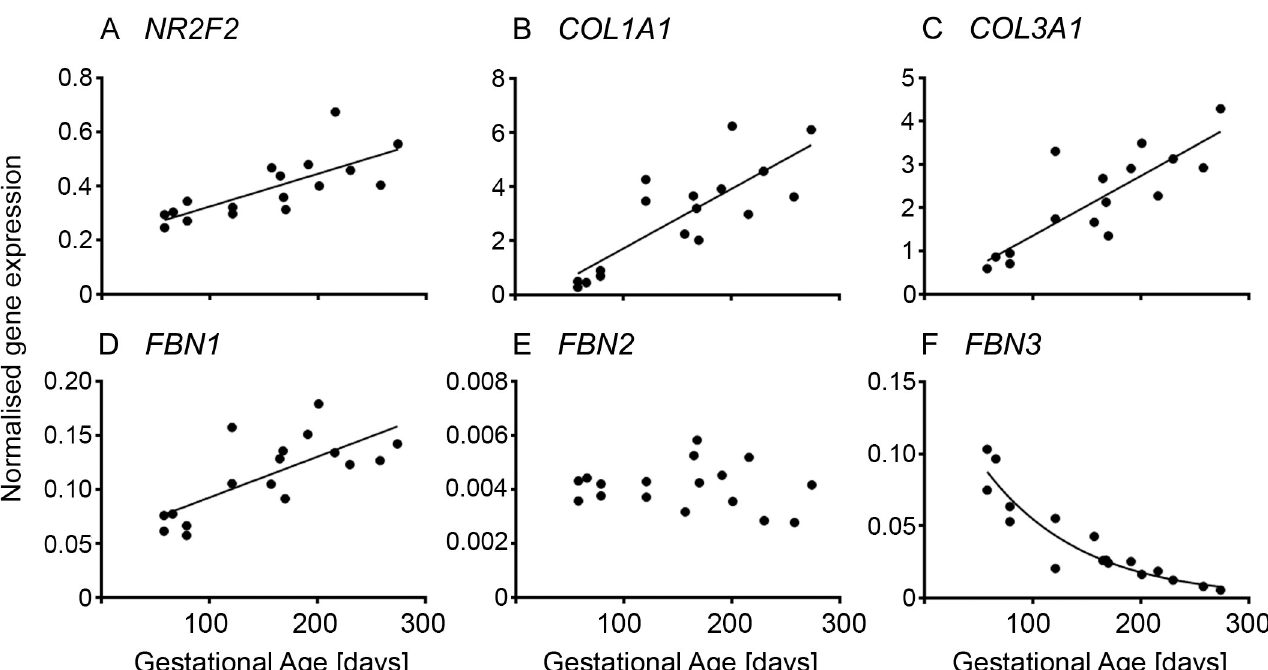
Fig 2. Stromal matrix and marker in fetal ovarian development. Expression levels of genes for each animal are plotted against gestational age in days (n = 16 or 17 animals).